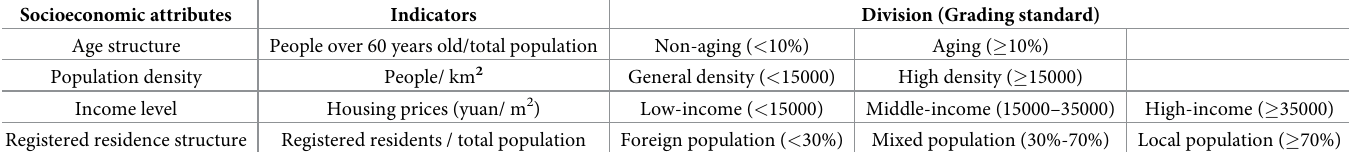
Table 2. Division and grading standard of community socioeconomic attributes in Shanghai.